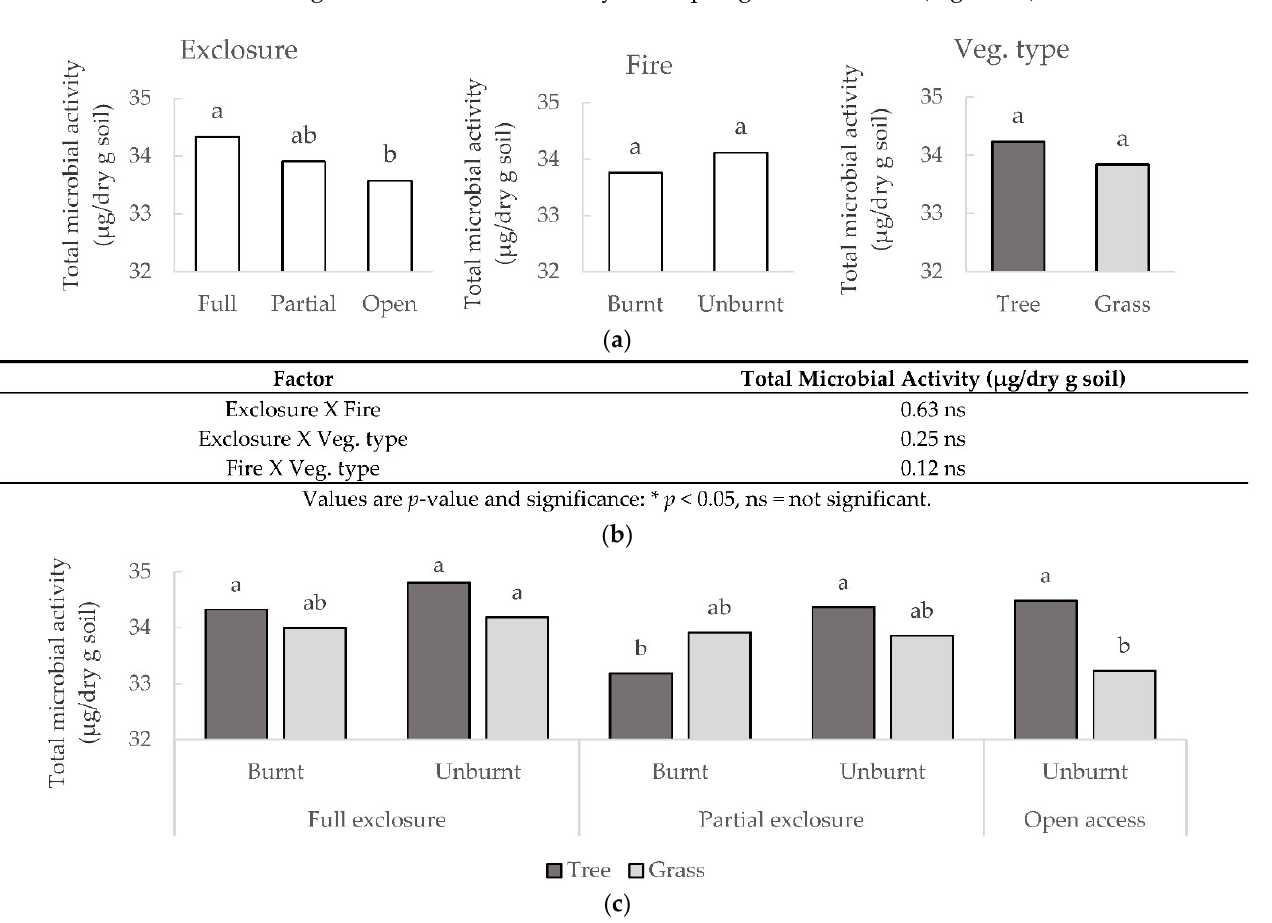
Figure 6. The main and interactive effect of herbivores, fire, and vegetation (veg.) type on total microbial activity: ( a ) independent effect; ( b ) two-way interactive effect; ( c ) three-way interactive effect).